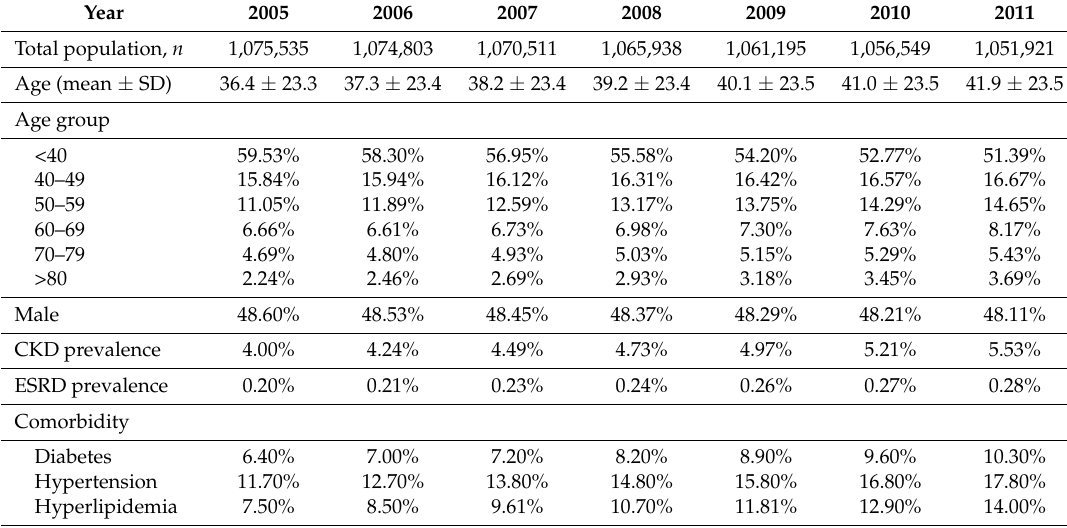
Table 1. The baseline characteristics of the study